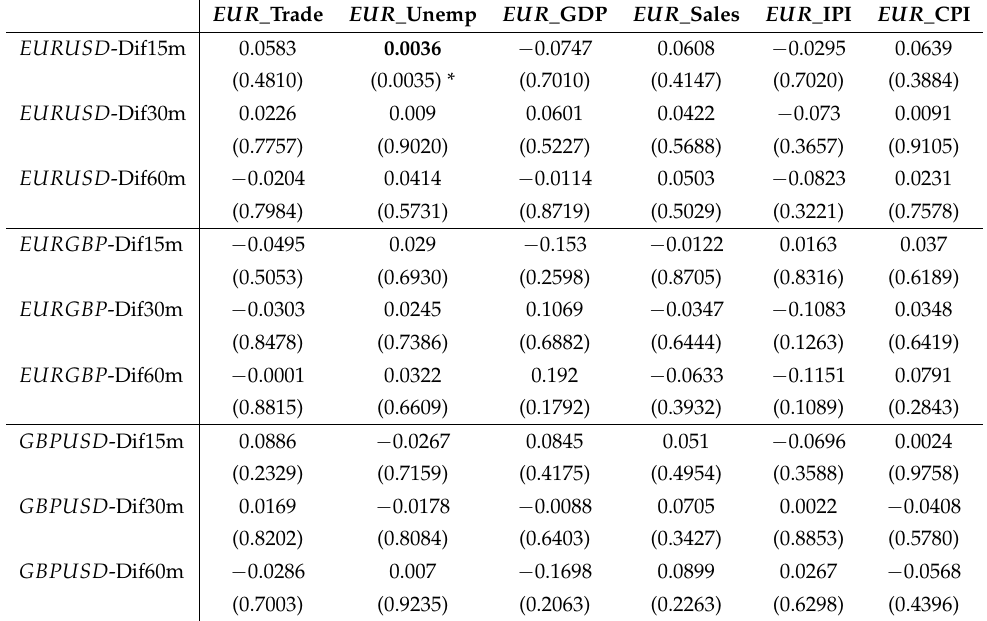
Table 3. Correlation coefficients for each news considered and currency movements for the three economic regions are shown from June 2007 to September 2022. p -values are written in parentheses. We marked in bold the correlation coefficients with values statistically different from 0. Those that are statistically significant at the 95% confidence level are marked with an asterisk